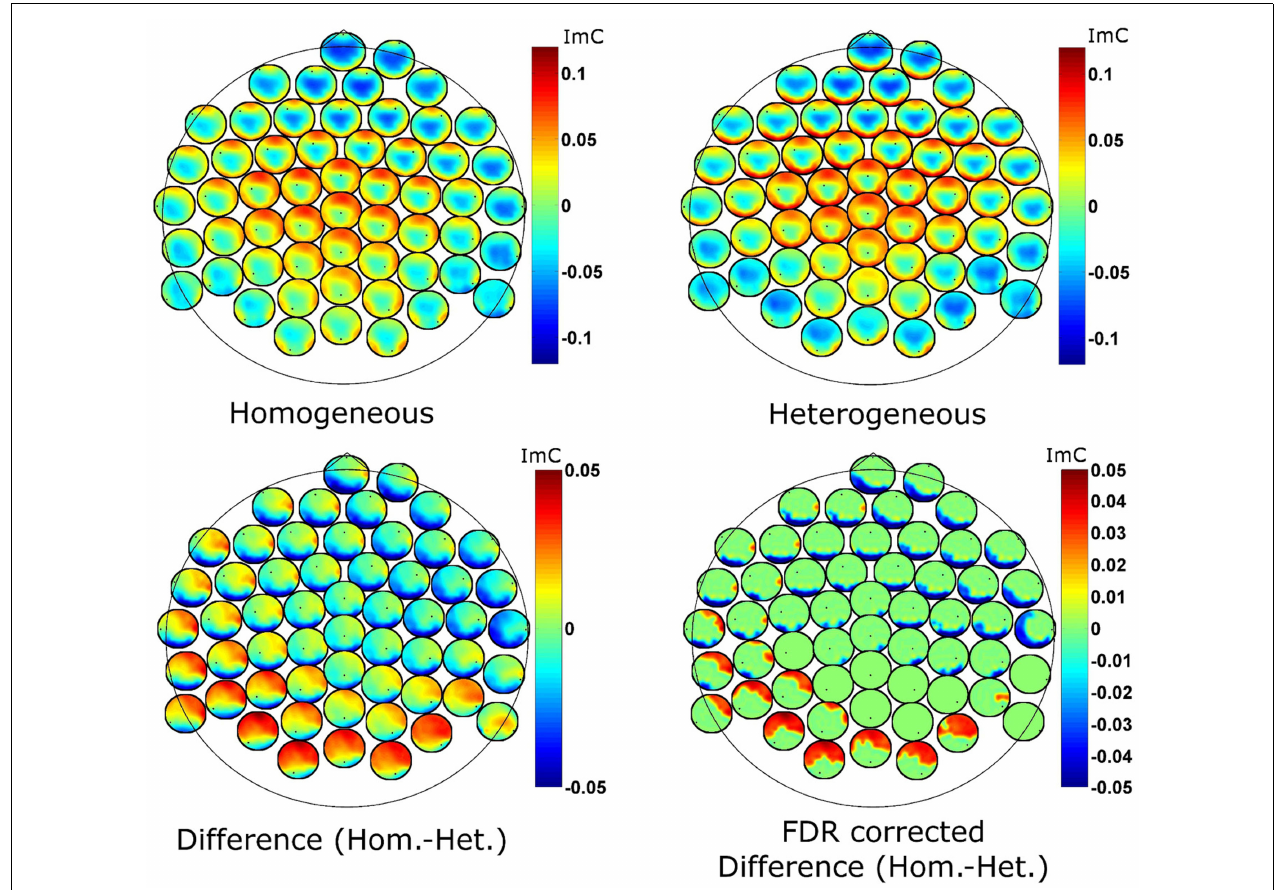
difference ( p = 0.1 after correction).The tiny black dots represent the position of the reference electrode in terms of connectivity. Hot as well as cold colors code strong connectivity.